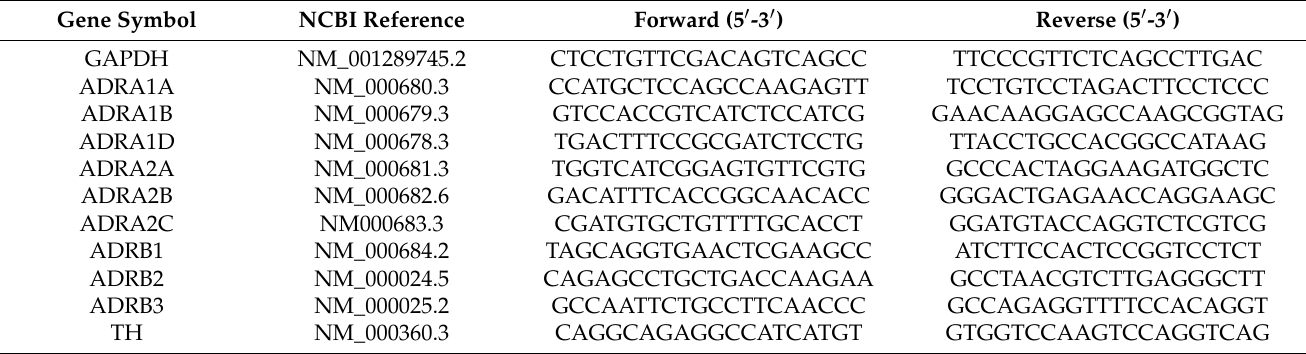
Table 2. The primers used for